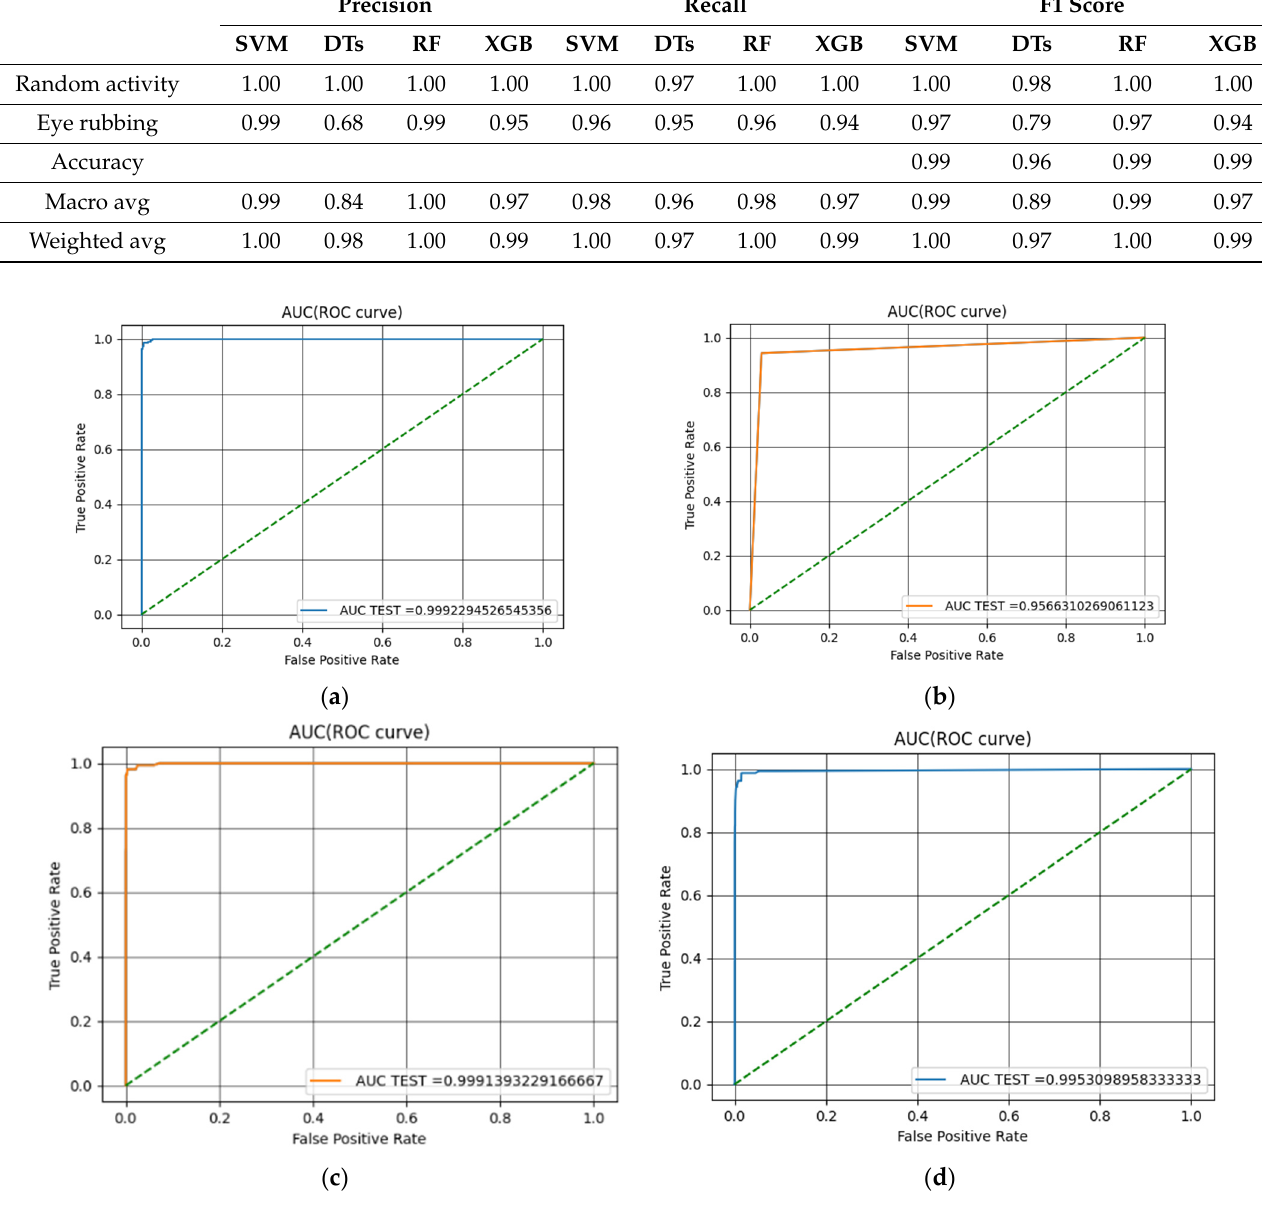
Figure 10. The AUC for the ( a ) SVM, ( b ) DTs, ( c ) RF, and ( d ) XGBoost classifiers.